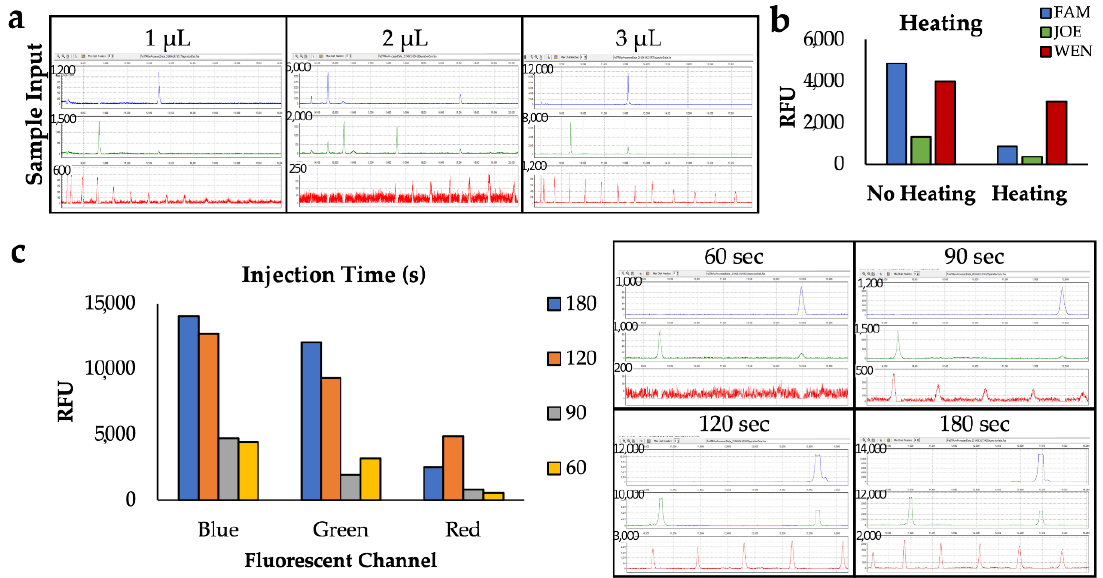
Figure 3. Optimization of separation parameters through comparison of electrophoresis peaks. ( a ) Resulting electropherograms from reagents containing 1, 2, or 3 µL of sample in a 13 µL sample volume. ( b ) Electrophoresis peak heights for each fluorescent channel in terms of relative fluores- cence units (RFU) comparing results when the separation channel is heated to 37 ◦ C or not heated. ( c ) Electropherograms showing the difference in peaks when injecting for 60, 90, 120, or 180 s, and a bar graph comparing the peak heights in terms of relative fluorescent